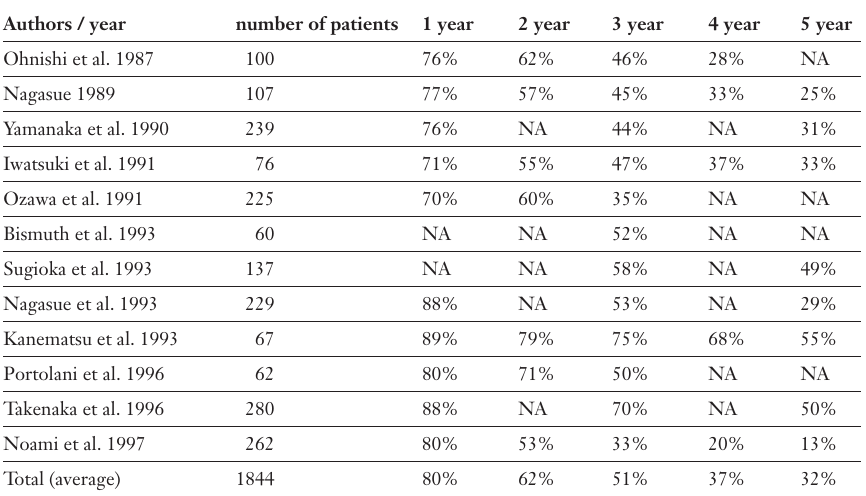
CT-scan showing a large unresectable HCC in a 47-year-old patient. The mass involves the entire right hemi-liver and segment IV including right portal vein thrombosis (fig. 2a). After 9 months of selective intra-arte- rial chemotherapy via the gastro-duodenal artery, the tumour shrunk dramatically with subsequent in- crease in size of the remaining healthy liver (segments II and III, fig. 2b). The patient underwent a curative extended right hemi-hepatec- tomy.